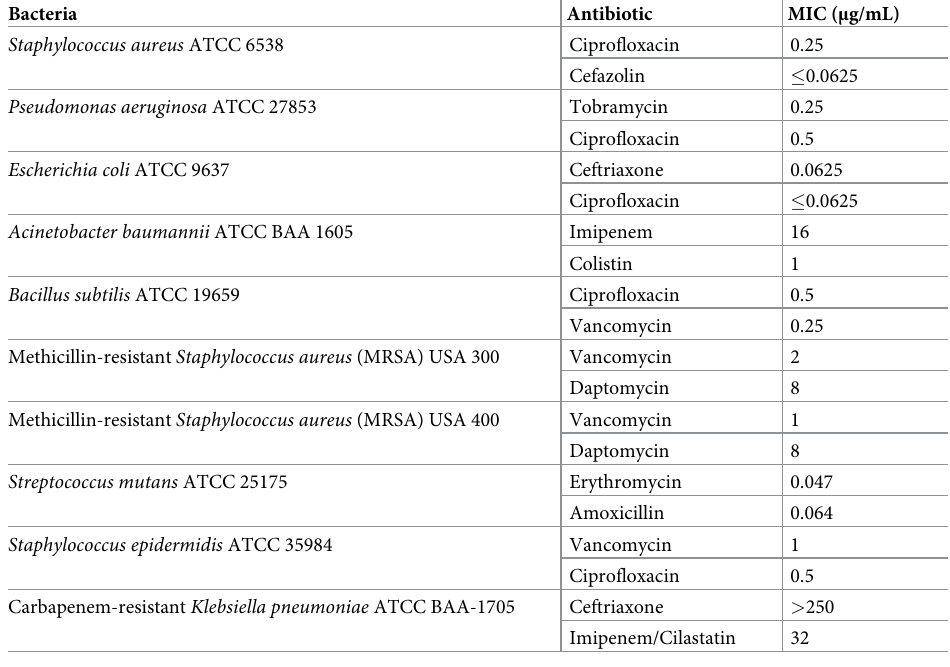
collagen (Table 3; e.g., p = 0.046 at 50 μ g/mL). The hypothesis was supported with both antibi- otics in this data set. Biofilms of E . coli ATCC 9637 had the most notable differences in susceptibility profiles between collagen and polycarbonate growth (Table 3). In all data sets, both ciprofloxacin and ceftriaxone were more effective against biofilms on polycarbonate than those on collagen with ceftriaxone having more polarized effect than ciprofloxacin (Table 3). Differences between Table 2. Bacteria and the antibiotics they were tested against, including MIC for